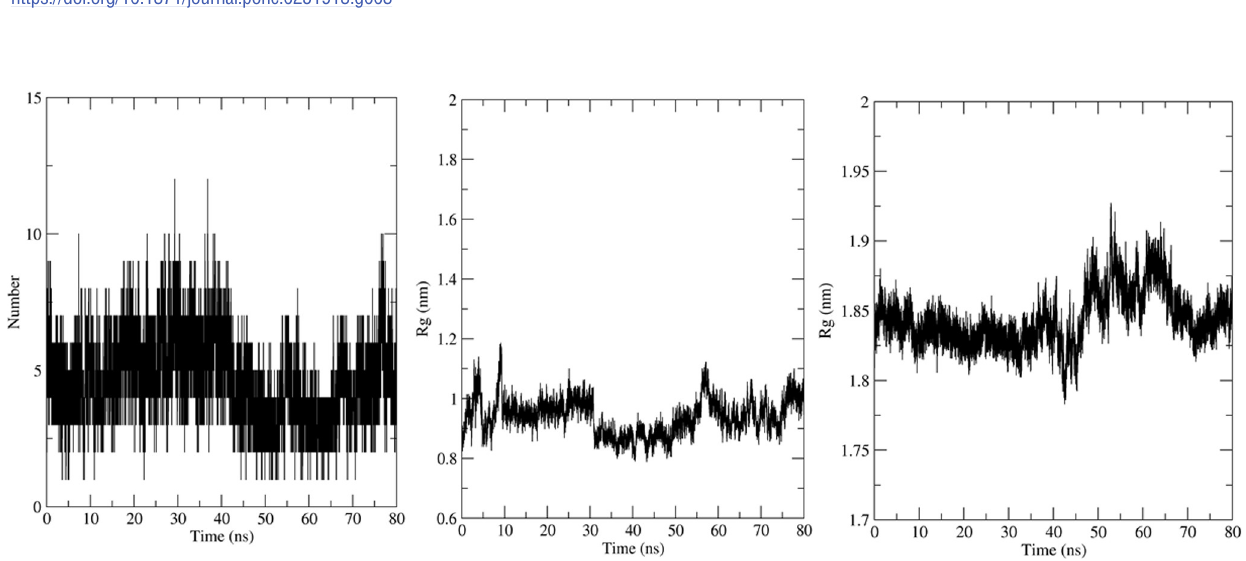
Fig 4. (a) Number of Hydrogen bonds in the MD simulation. (b) Radius of gyration (Rg) of the Peptide 7 in complex and (c) SARS-CoV-2-RBD in complex.